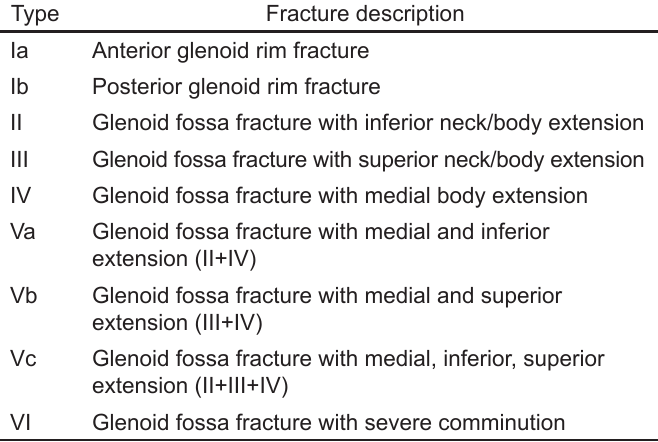
Table. Ideberg classification of glenoid